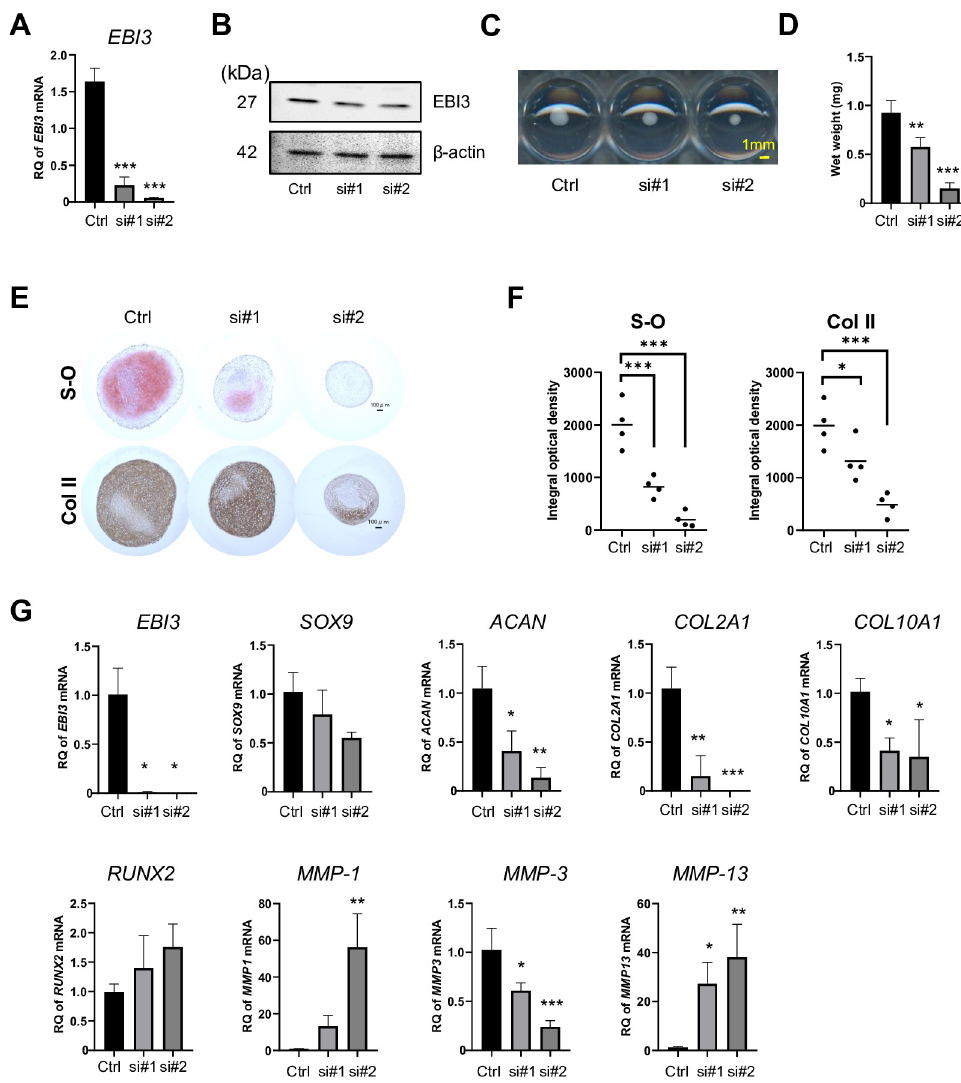
Fig 2. Endogenous EBI3 enhances chondrogenic differentiation of MSCs. (A-G) MSCs were transfected with control siRNA or 2 different EBI3 siRNAs (si#1 and si#2). (A) EBI3 mRNA levels were evaluated by RT-qPCR at 48 hrs after transfection. (B) EBI3 protein levels were evaluated by western blotting at 48 hrs after transfection. β -actin was used as a loading control. (C-G) MSCs were cultured as pellets in chondrogenic medium for 21 days after transfection. (C) Photographs of the pellets. Scale bar, 1 mm. (D) The wet weight of the pellets. (E) The pellets cultured were stained with Safranin-O (S-O) or anti-type II collagen (Col II) antibody. Scale bar, 100 μ m. (C and E) Results are representative of 4 independent experiments with similar findings. (F) Densitometric analysis of the staining in (E) was performed and shown by integral optical density (IOD). (G) The mRNA levels of the indicated genes in transfected pellets were determined by RT-qPCR. (A, D, F, and G) Quantified data are expressed as the mean ± SD (each n = 3 in A; n = 4 in D; n = 4 in F ; n = 3 in G ) with similar findings. � = P < 0.05; �� = P < 0.01; ��� = P < 0.001 by Dunnett’s multiple comparison